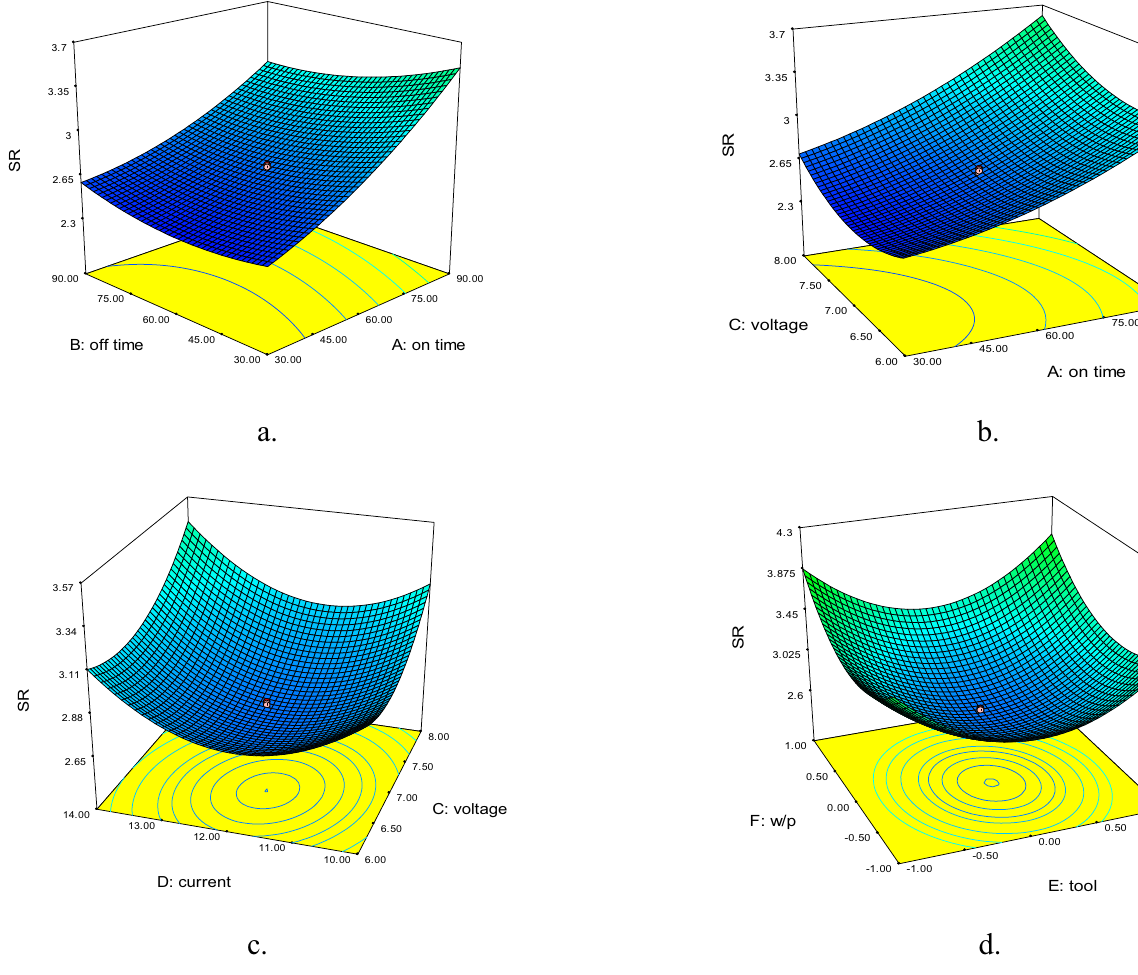
Figure 12: ( a ) Interaction e ff ect of P on and P o ff on SR height ( R a in µm ) , ( b ) interaction in fl uence of voltage and P on on SR height ( R a in µm ) , ( c ) interaction in fl uence of voltage and current on SR height ( R ( R ) a in µm